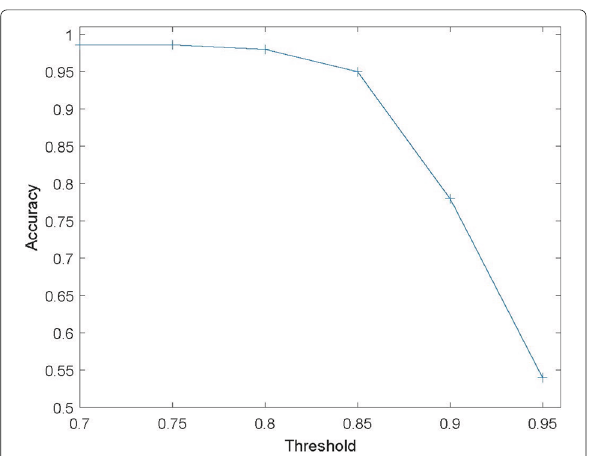
Fig. 5 Accuracy of cross-layer construction along with variation of the